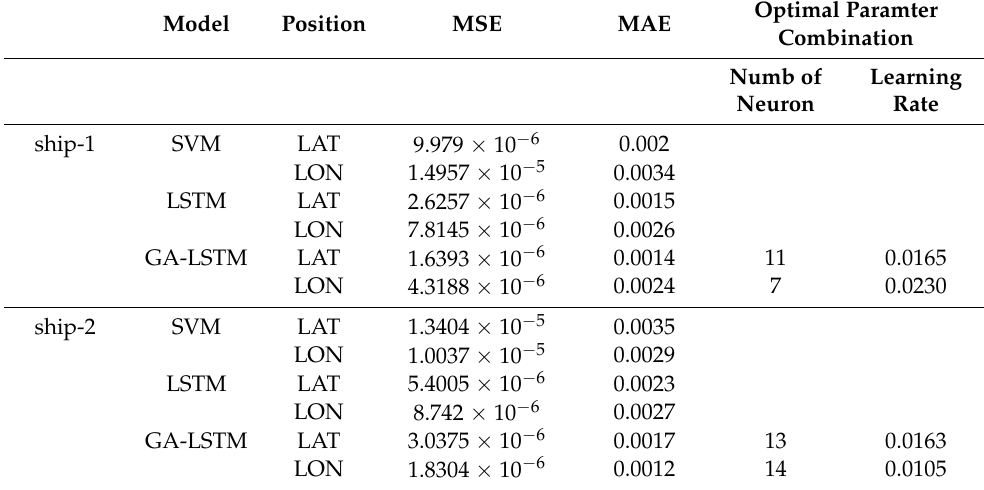
Table 2. Performance index analysis of models on 3 models.